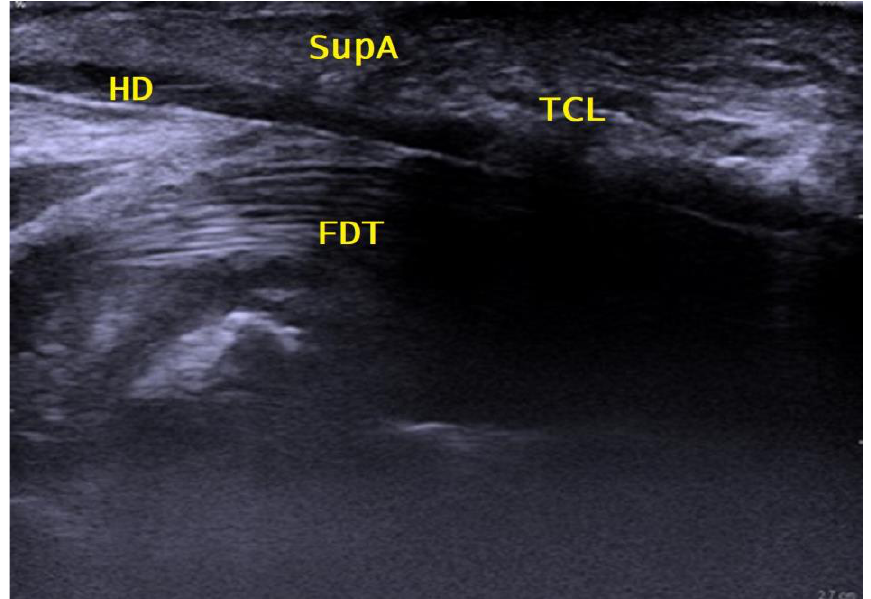
Figure 2. Sagittal proximal palmar view. HD = hydrodissected area; FDT = flexor digitorum profundus and superficialis tendons; TCL = transverse carpal ligament; SupA = superficial palmar aponeurosis.